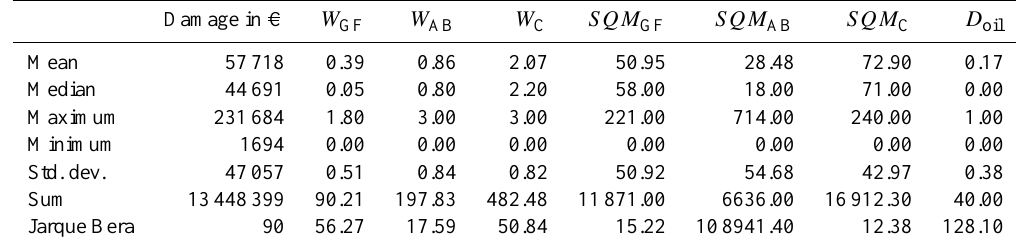
Table 3. Descriptive statistics of parameters/attributes for the damage